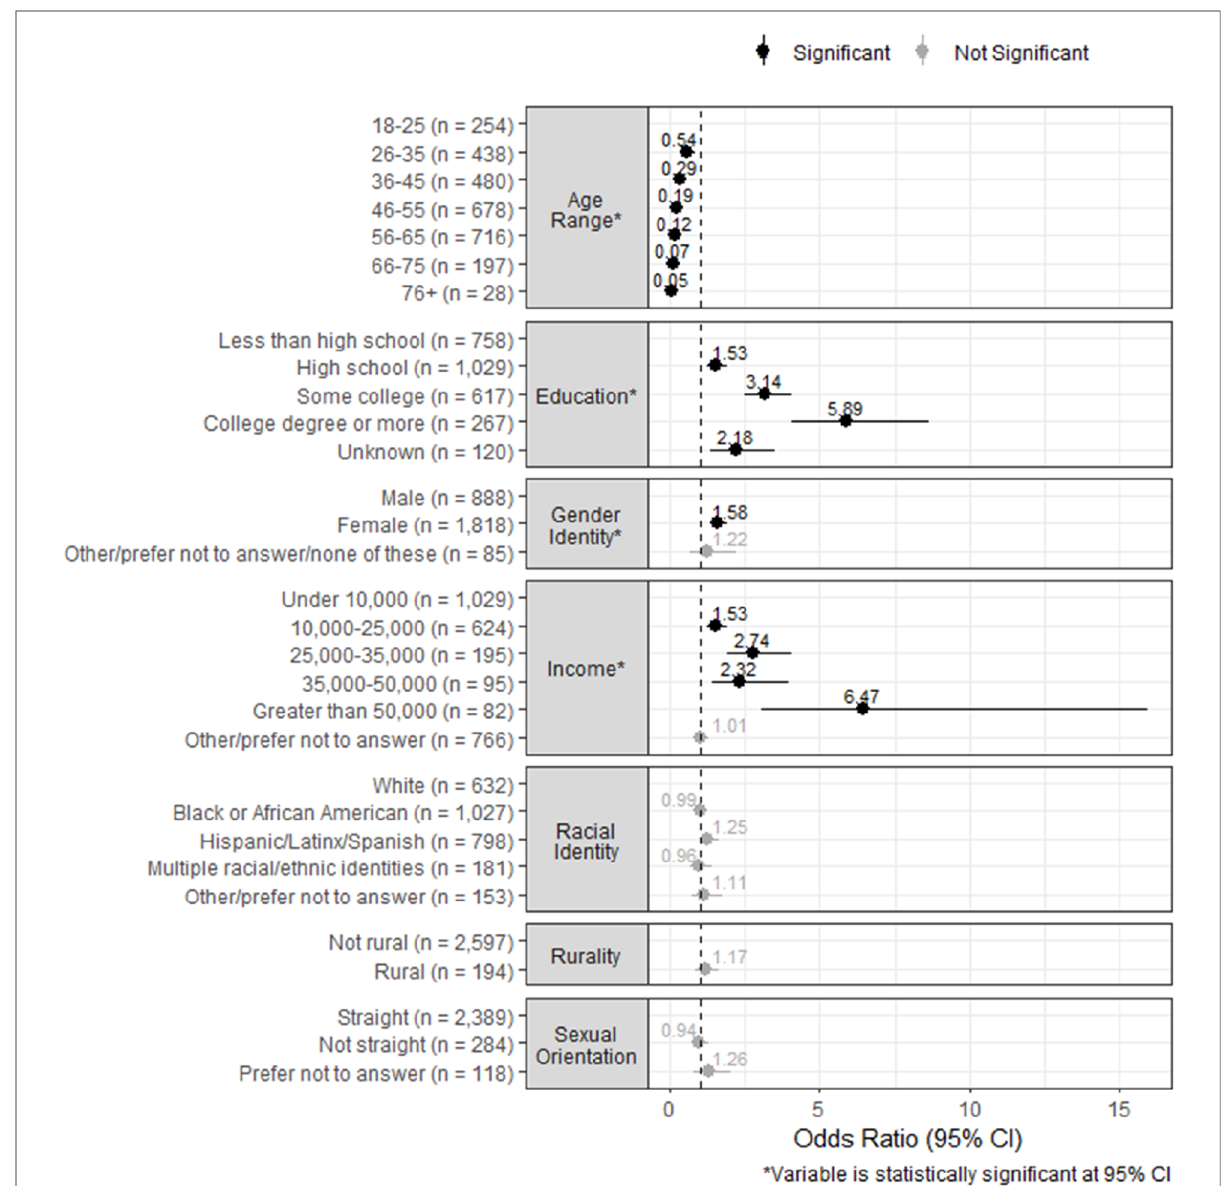
FIGURE 2 Results from the model to understand characteristics of groups that are not digitally ready at FQHCs. (Outcome variable: Digital Readiness. Coded as 1 if the participant was digitally ready, and 0 if the participant was not digitally ready. Digital readiness was de fi ned by access to home-based or other internet-accessing devices (computers, tablets, mobile phones, and other devices) and participants ’ comfort level using such